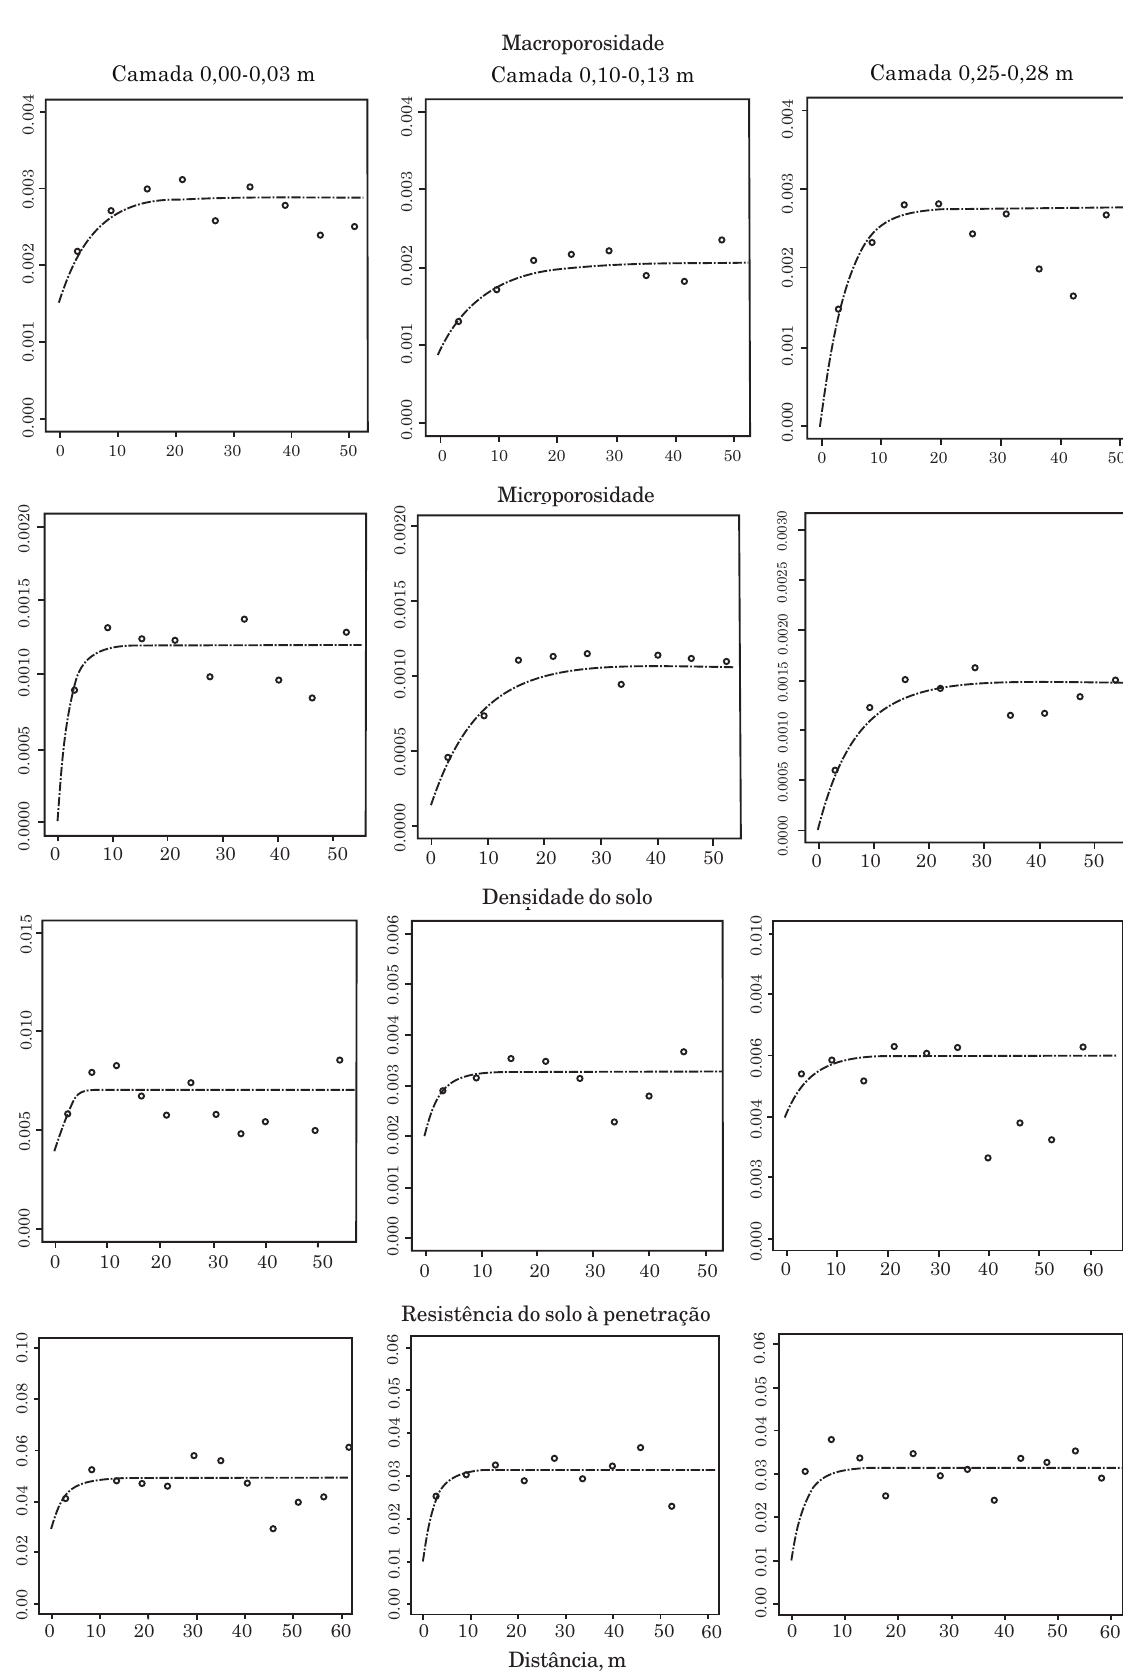
Figura 2. Semivariogramas para os atributos físicos estudados, nas três camadas amostradas.